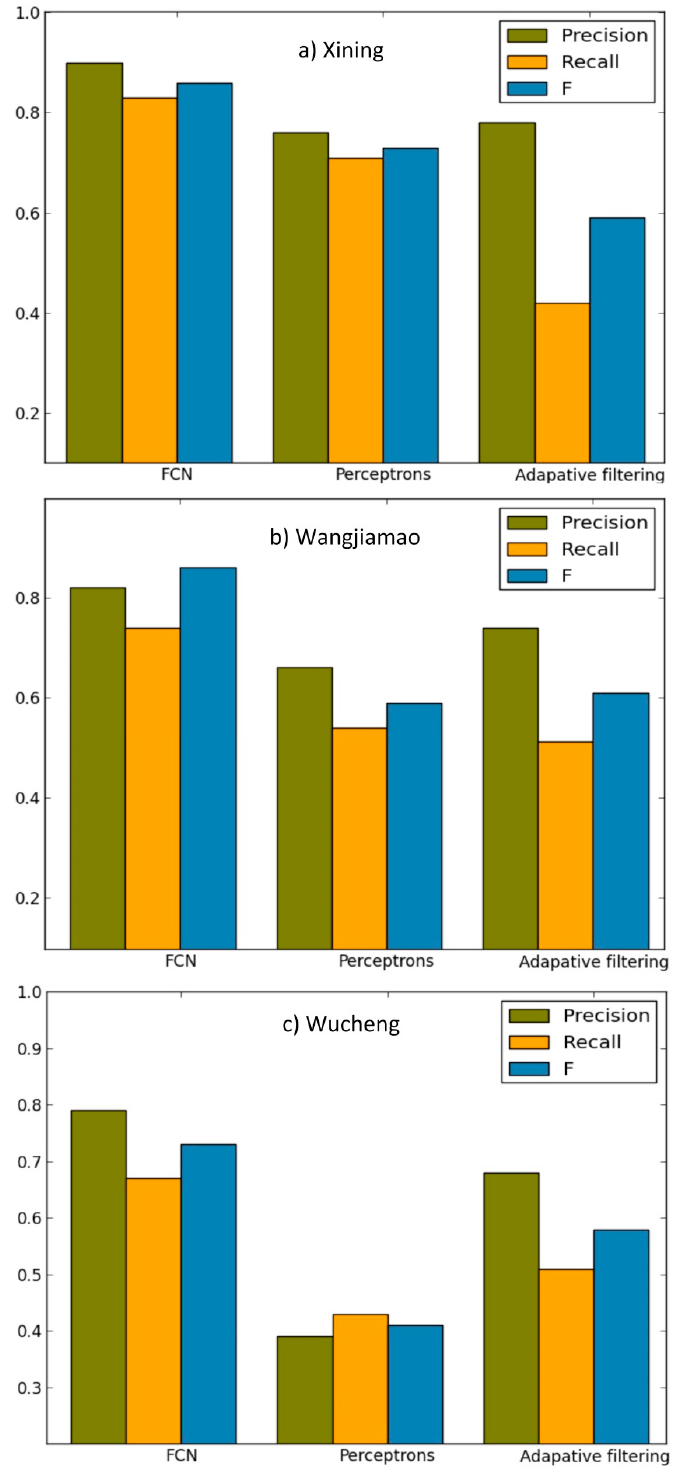
Figure 9. Comparison of accuracy under three methods (FCN by our U-net based method, Perceptrons by Kwak et al., 2007 and Adapative filtering by Hu et al., 2019). ( a ) Xining; ( b ) Wangjiamao; and ( c ) Wucheng. Dark green, orange, and blue bars are Precision, Recall, and F-value respectively.